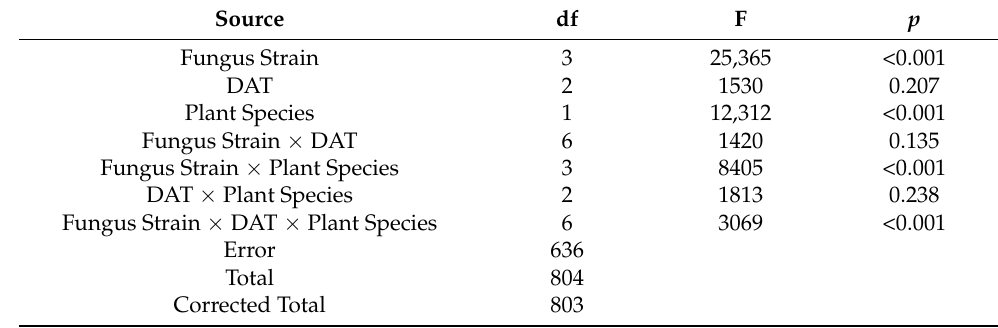
Table 1. ANOVA results for main effects and interactions for the intensity of B. bassiana